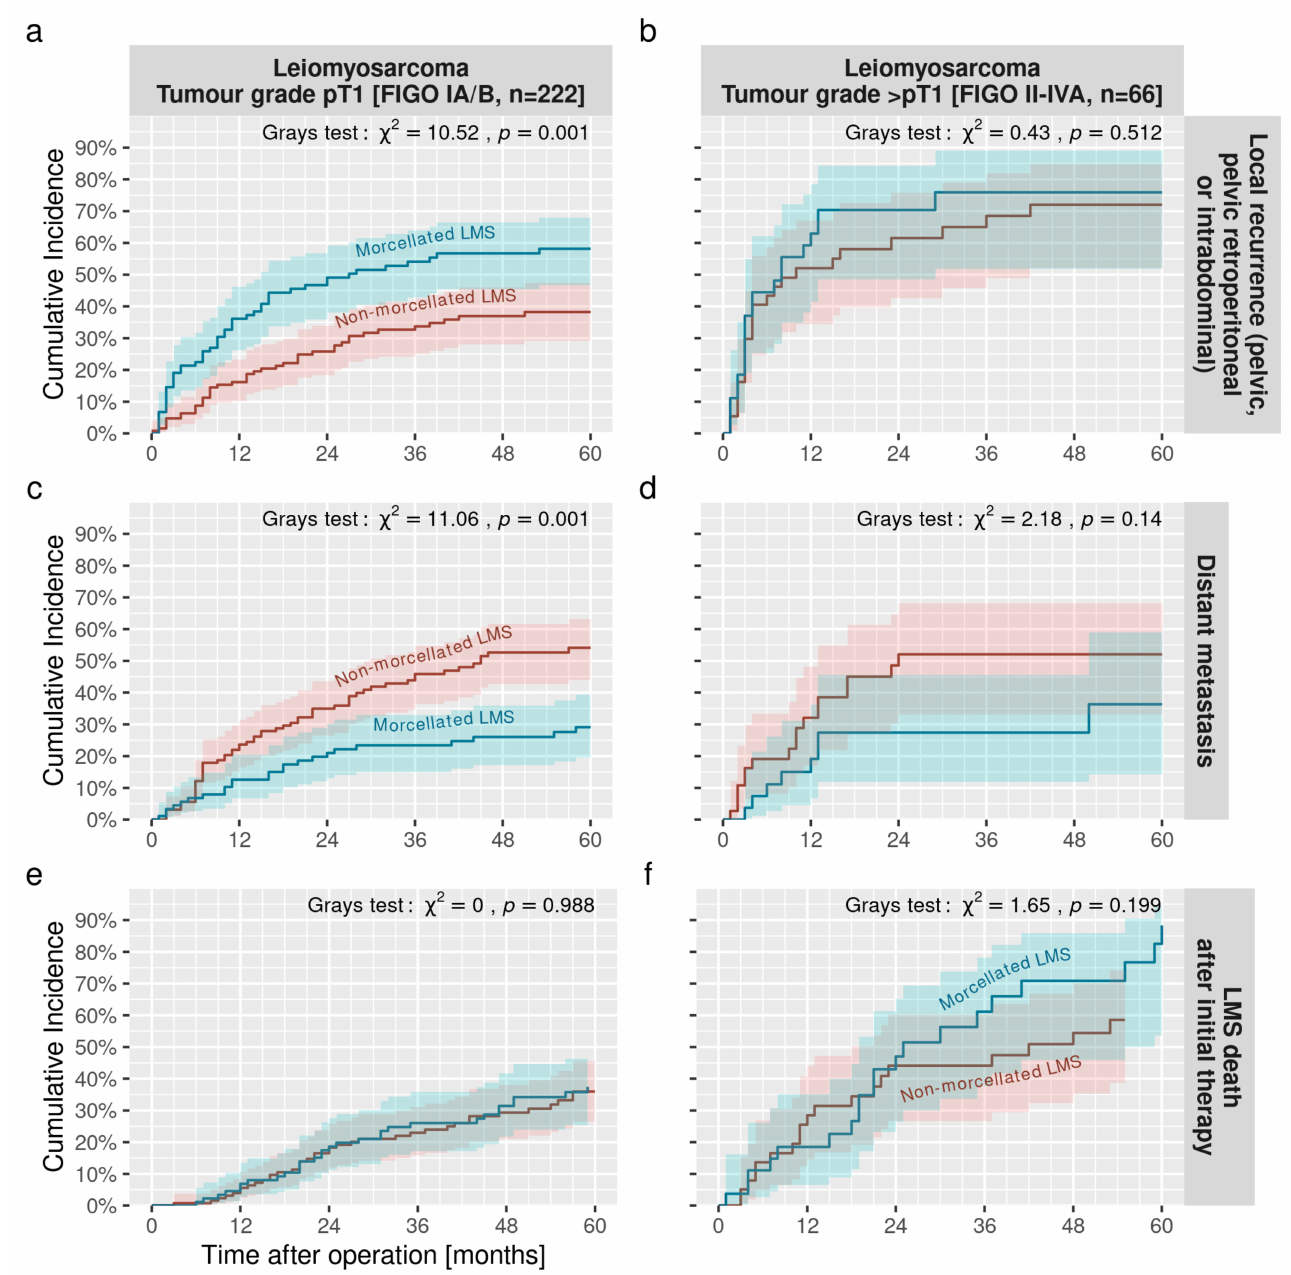
Figure 1. Cumulative incidence rates of the time to local recurrence (top), distant metastases (middle), and LMS mortality (bottom) are plotted in relation to LMS morcellation at stages pT1 (left panel ( a , c , e )) and >pT1 (right panel ( b , d , f )). Blue curves showing morcellated, red curves showing non-morcellated LMS with 95% confidence bands,